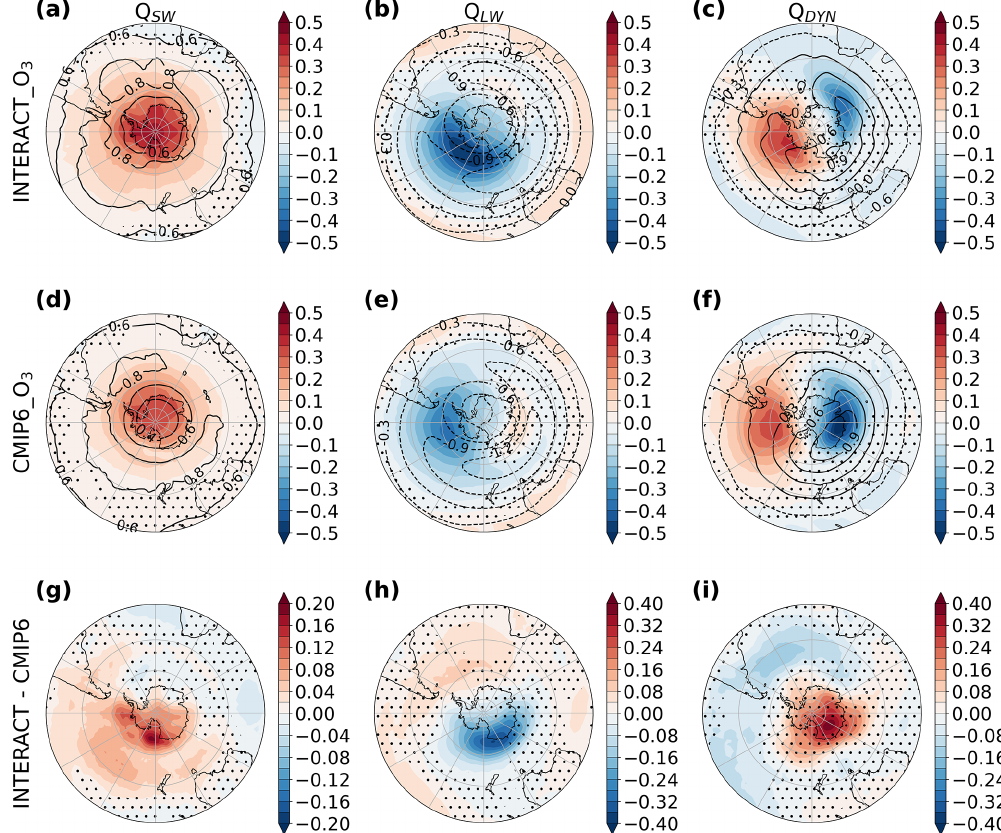
Figure 9. Changes in the SW (a, d) , LW (b, e) , and dynamical (c, f) heating rate (Kd − 1 ) at 50hPa during October due to ozone recovery and GHGs combined, in INTERACT_O 3 (a–c) and CMIP6_O 3 (d–f) , and the difference between the INTERACT_O 3 and the CMIP6_O 3 changes (g–i) . The stippling in (a) – (f) masks regions where the changes are not significant at the 95% confidence interval based on a two- tailed t test, and the stippling in (g) – (i) masks regions where the difference is lower than 2 σ inferred from the spread of the individual ensemble members. The contours in (a) – (f) show the current-day (2011–2030) climatologies in the respective